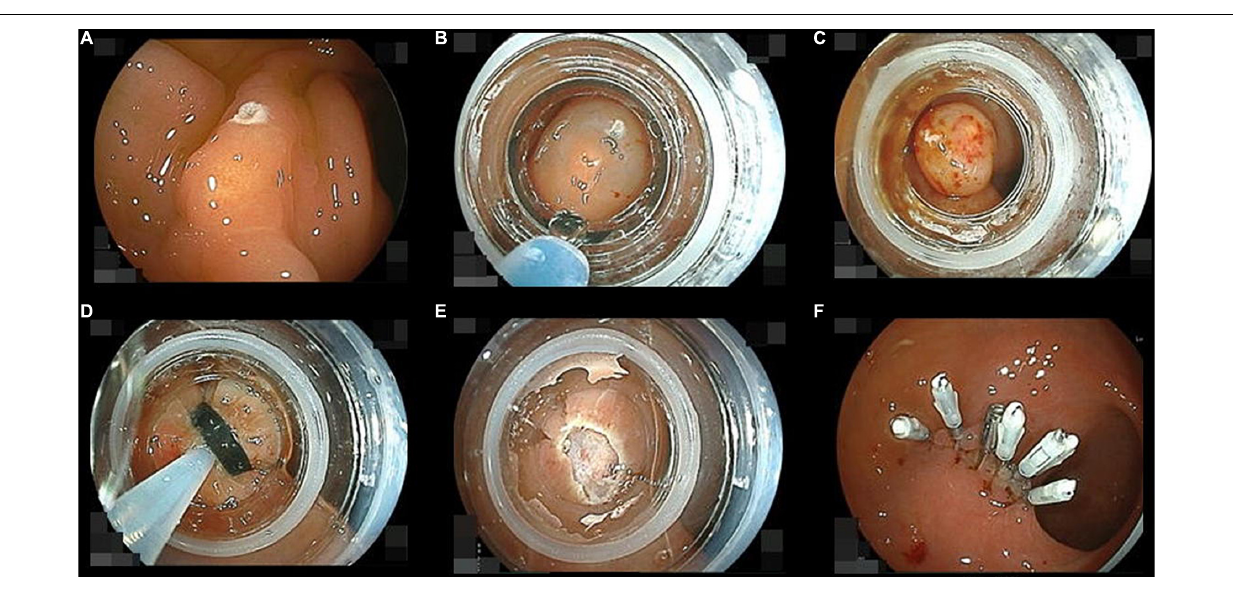
FIGURE 3 | Pictures of the endoscopic submucosal resection with a ligation device sequence. (A) Marking a neuroendocrine tumor (NET) using the tip of a loop snare with soft-coagulation mode. (B) Injecting saline into the submucosa below the NET just before following band ligation. (C) The NET ligated with a rubber band involving its surrounding mucosa and submucosa. (D) Snaring under the ligation band. (E) Cutting the ligated them with forced-coag-1 mode. (F) The wound was closed with endoclips as soon as possible after removal of the cap.